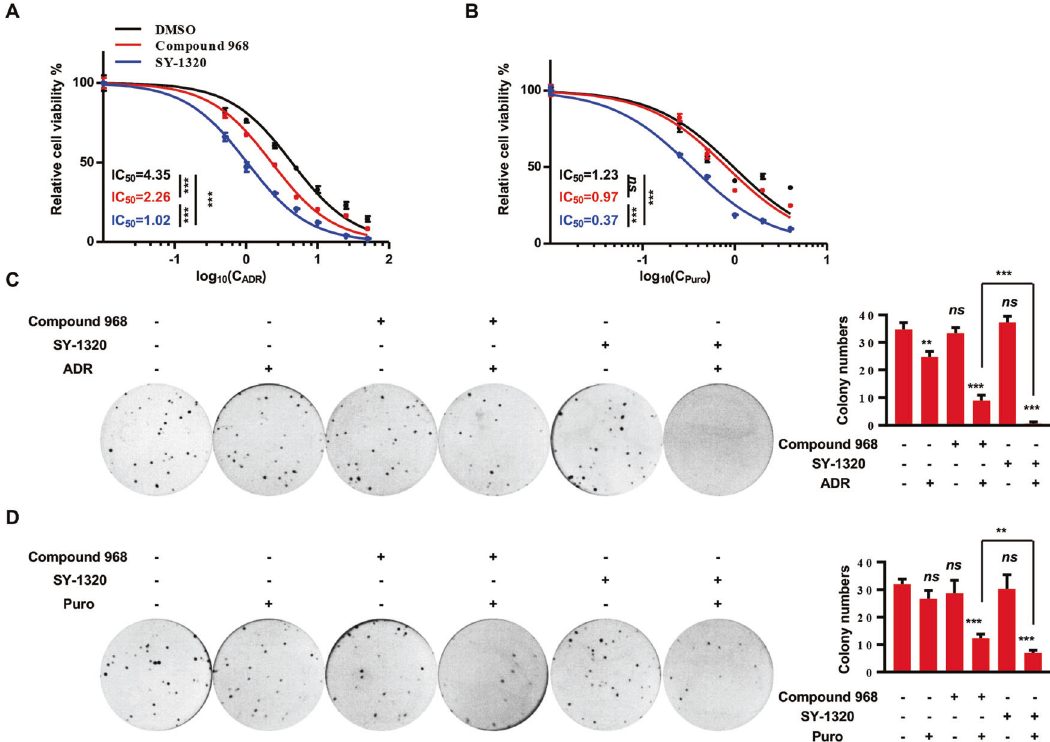
Fig. 3 SY-1320 reverses multidrug resistance in MCF-7 ADR cells. A , B MCF-7 ADR cells were treated with a series of concentrations of ADR ( A )/ Puro ( B ) alone or combined with 2 µM compound 968 or SY-1320 for 48 h. Cell survival was measured using the CCK8 assays. C , D MCF-7 ADR cells were treated with the compounds as indicated for 2 weeks, and cell colonies were stained with crystal violet. In all, 1 µM compound 968, 1 µM SY-1320, 0.5 µM ADR, and 0.2 µg/mL Puro were used. Data are presented as mean ± SD of three independent experiments. ns no signi fi cance; ** P < 0.01, *** P < 0.001, one-way ANOVA ( A , B ) and two-tailed Student ’ s t test ( C , D